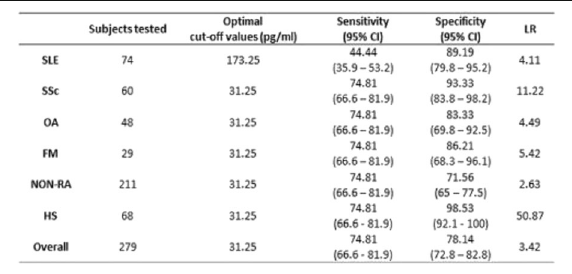
Table 1 (abstract O70). Diagnostic performance of serum IL-22 in distinguishing RA patients from non-RA patients and healthy